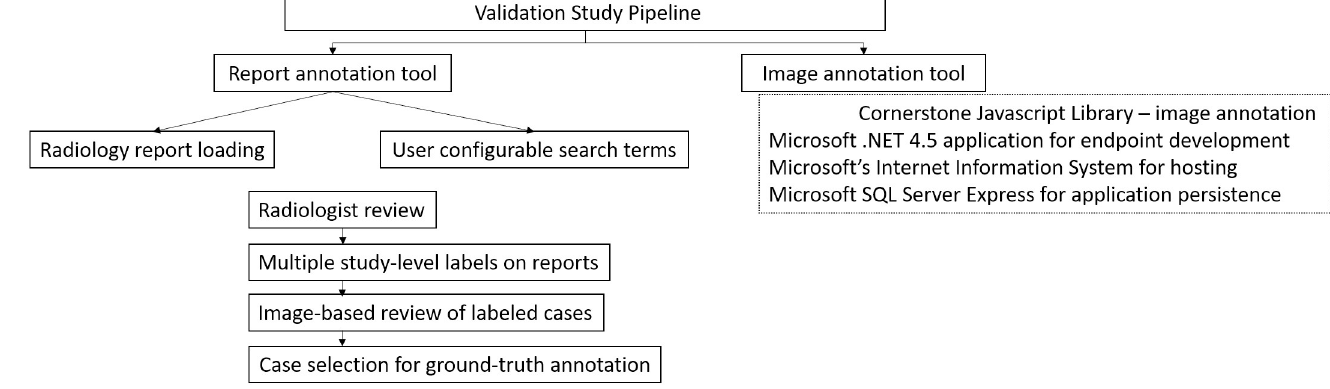
Fig 2. Infrastructure of validation pipeline for AI algorithms assessed in our study.